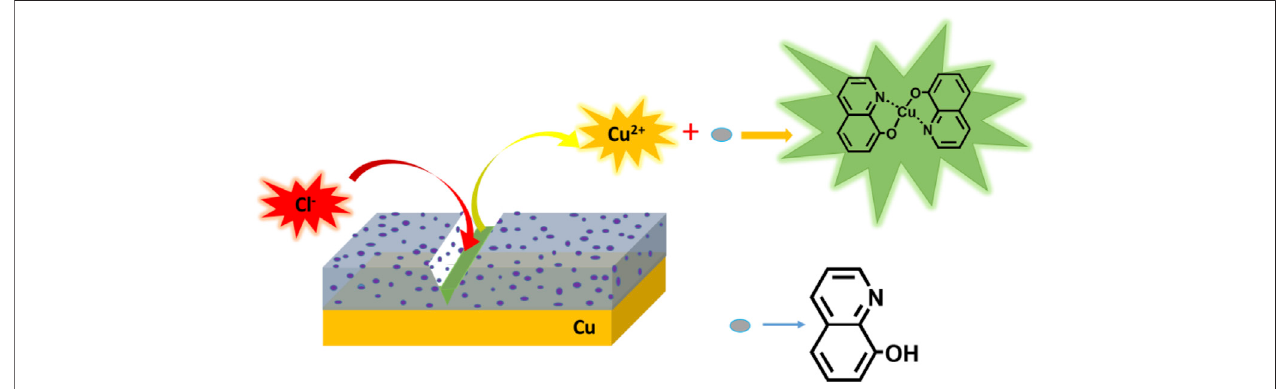
SCHEME 1 | Cartoon of the self-healing effect of PDA@8-HQ